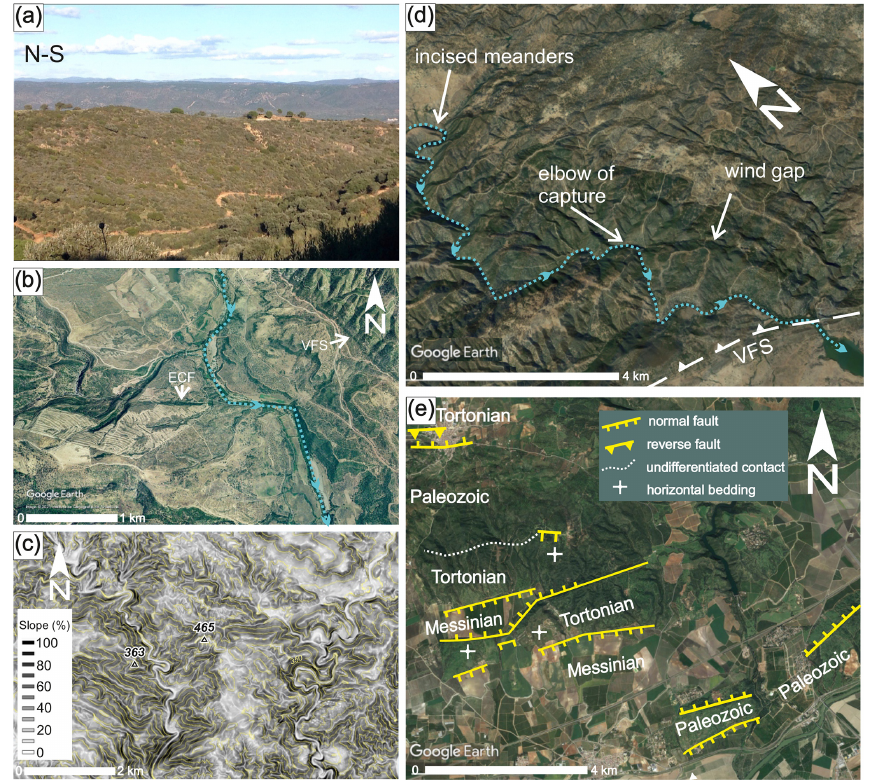
Figure 3. (a) Relict peneplain on top of the Ossa-Morena zone (background), just east of the Viar basin. The photograph is taken from the south Portuguese zone (foreground), with the location given in Fig. 2a. (b) Google Earth view of the River Viar deflection associated with the Embalse del Cala fault (ECF). The image was taken in 2022. © Instituto de Cartografía de Andalucía from 2004, before the current dam construction, with the location given in Fig. 2a. (c) Slope and topographic map (equidistance 50m) showing incised meanders in S6, with the location given in Fig. 4a and the altitude base and reference system as in Fig. 1. (d) © Google Earth 2019. Oblique view showing a stream elbow testifying to a piracy along the River Viar at its intersection with the Viar fault system (VFS), with the location given in Fig. 2a. (e) Faults related to the NNW–SSE relief segmentation defining horsts and grabens in the southernmost Sierra Morena (see the location in Fig. 1b). The faults are drawn on a © Google Earth image from